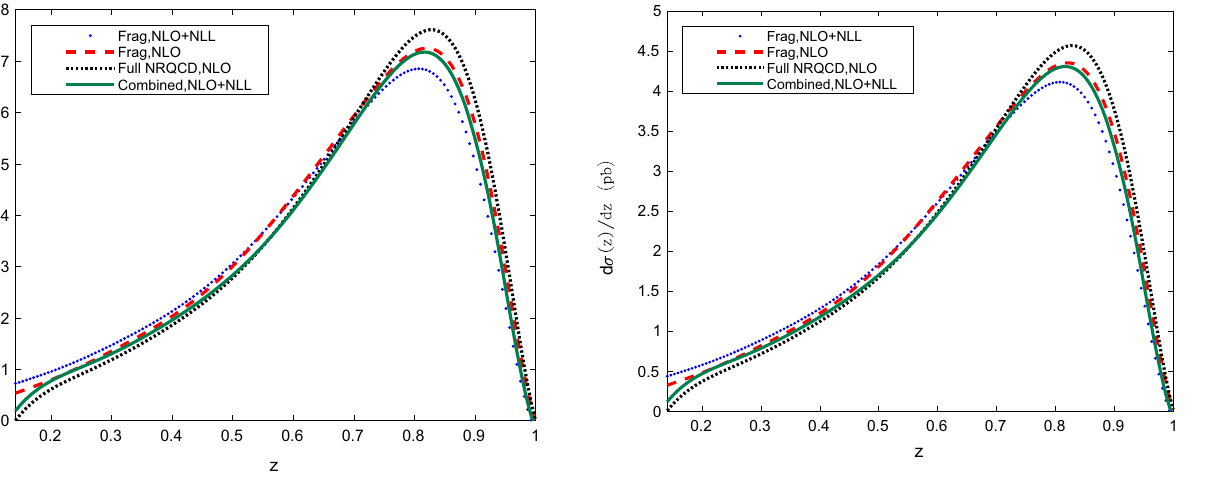
Fig. 8 The differential cross sections d σ/ dz for the production of the B ∗ c ( 2 3 S 1 ) meson at the Z pole under different